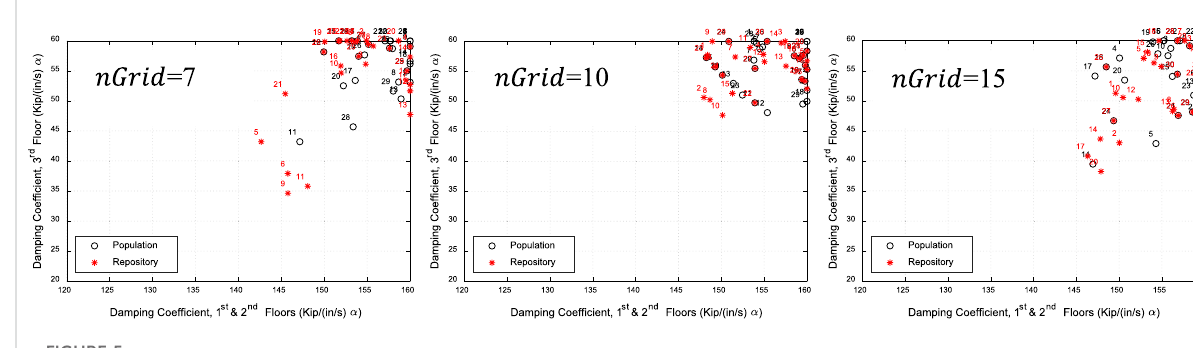
FIGURE 5 Effect of density of search space, nGrid , on the design variable outcomes ( nPop (cid:2) 30; nIter (cid:2) 5).